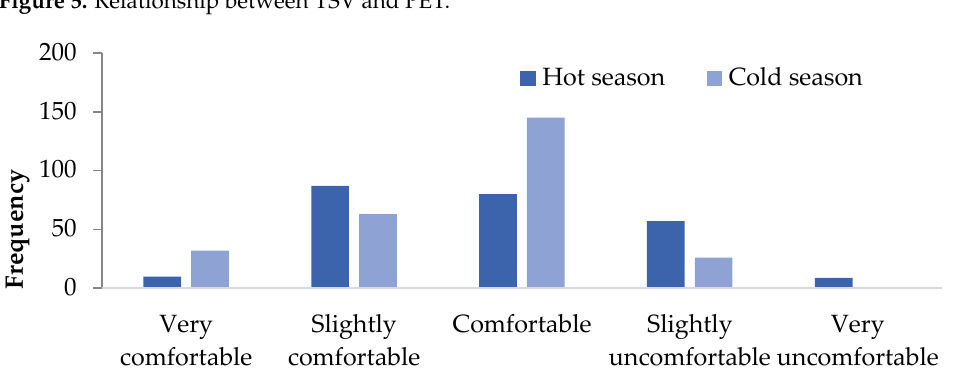
Figure 6. TCV frequency